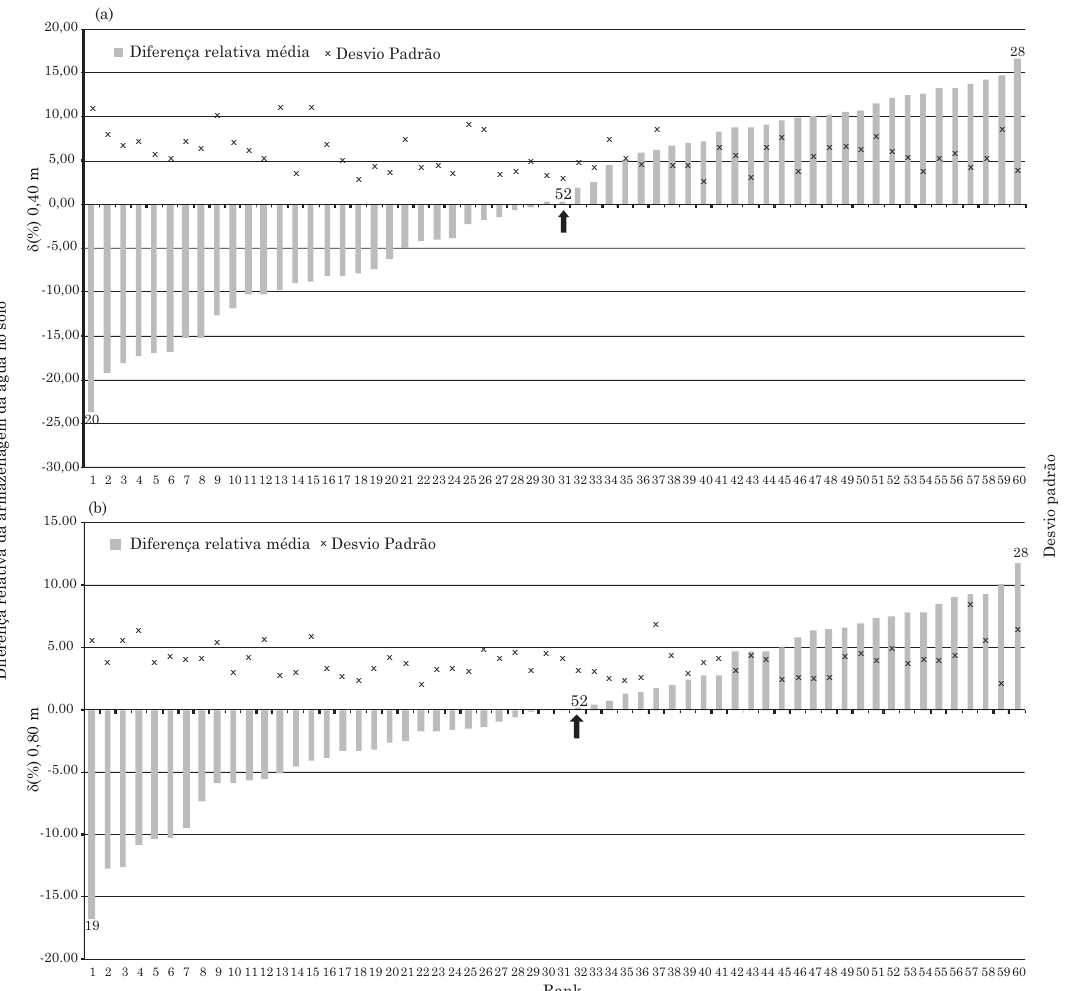
Figura 4. Diferença relativa média no tempo para a armazenagem de água no solo a 0,40 m (a) e 0,80 m (b) e respectivo desvio-padrão no tempo obtido durante o ciclo do feijoeiro. Números referem-se aos pontos de